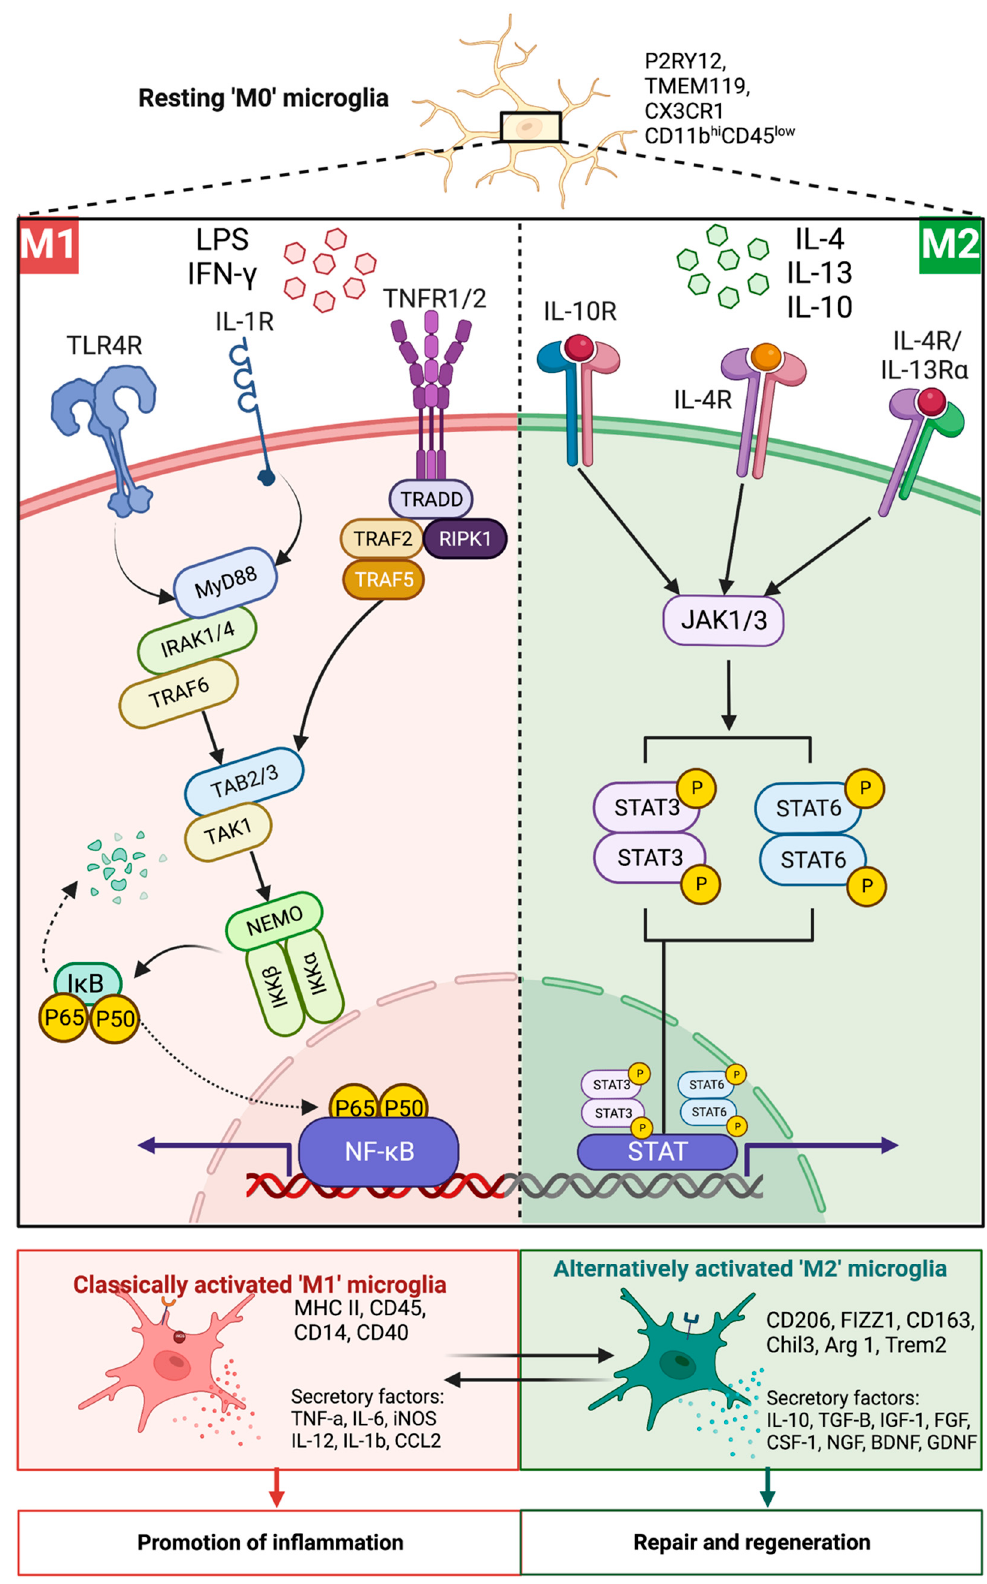
Figure 1. The mechanistic activation of classically activated ‘M1 ′ and alternatively activated ‘M2 ′ microglia. In the presence of interferon-gamma (IFN- γ ) and lipopolysaccharides (LPS), the resting ‘M0 ′ microglia undergo polarization towards the classically activated ‘M1 ′ proinflammatory phenotype by activation of the nuclear factor kappa beta (NF- κ B)-dependent pathway. In contrast, the IL-4, IL-10 and IL-13 cytokines trigger signal transducer and activator of transcription (STAT)3/STAT6